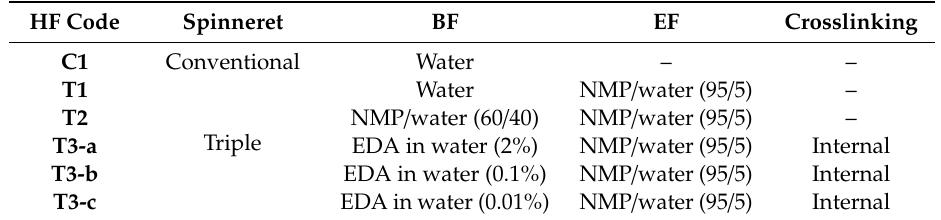
Table 1. Composition (weight basis) of bore fluid (BF) and external fluid (EF) for the preparation of the HF batches. NMP— N -methyl-2-pyrrolidone; EDA—ethylene diamine.